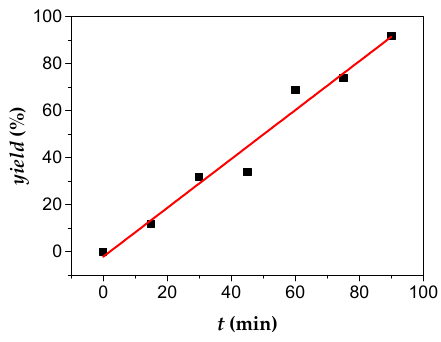
Figure 5. Polymerization of NBD (0.8 mL, 725.0 mg, 8.5 mmol) with 1 (30 mg, 0.017 mmol), AgBF 4 (13.3 mg, 0.069 mmol) and 5 mL CH 2 Cl 2 (25 °C); % yield vs. time plot of PNBD.